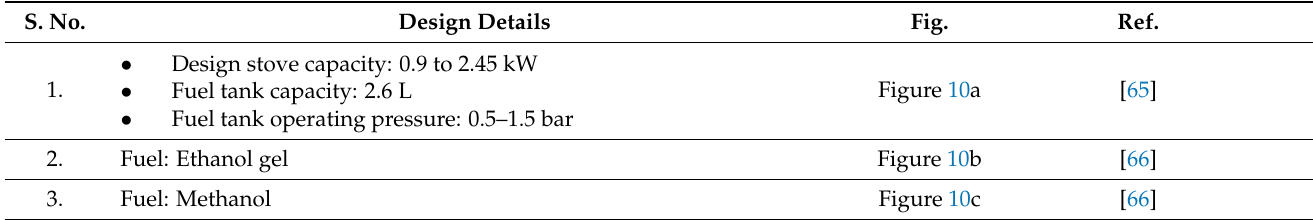
Table 3. Summary of the alcohol-based cook-stoves. Design Details Fig. Ref.